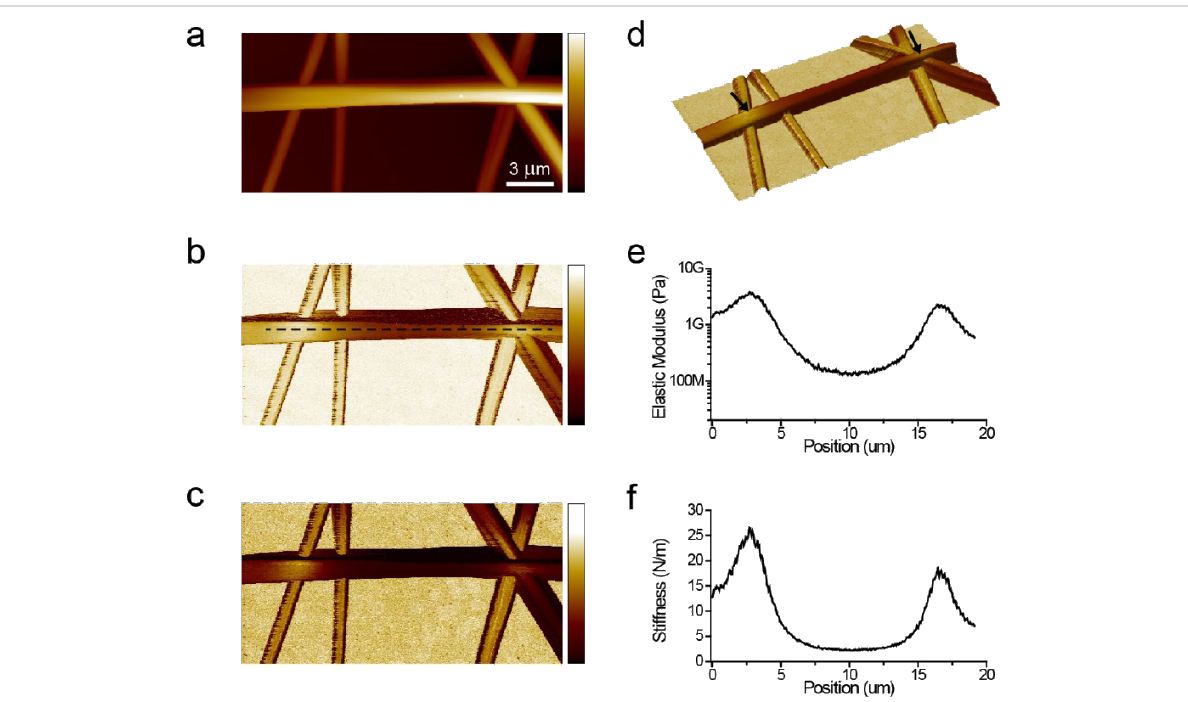
Figure 2: Simultaneously measured topography (a), elastic modulus (b), and stiffness (c) maps obtained from electrospun silk fibers. Color bars in (a–c) correspond to the ranges in height (0–1.8 µm), elastic modulus (10 MPa to 10 GPa, mapped logarithmically), and stiffness (0–5 N/m). The hori- zontal fiber appears to be suspended above the glass substrate. A 3-D rendering of the topography image is given in (d). The fiber is suspended between positions indicated by arrows in (d). This image is colored according to the local spring constant. Both the elastic modulus and stiffness maps show gradual variations across the suspended silk fiber. Line profiles of elastic modulus and stiffness across the dashed line in (b) are given in (e) and (f), respectively. While the local elastic modulus of the silk fiber is likely to be constant across the length of the fiber, the values in (e) show signifi- cant variation. This is because the elastic modulus values in (b,e) are calculated by the DMT contact-mechanics model, which does not take the suspended geometry of the fiber into account. Therefore, the regions of the elastic modulus image corresponding to suspended fibers are not reliable. These regions are better analyzed in the light of mechanical models describing the entire suspended structure by using the stiffness values in